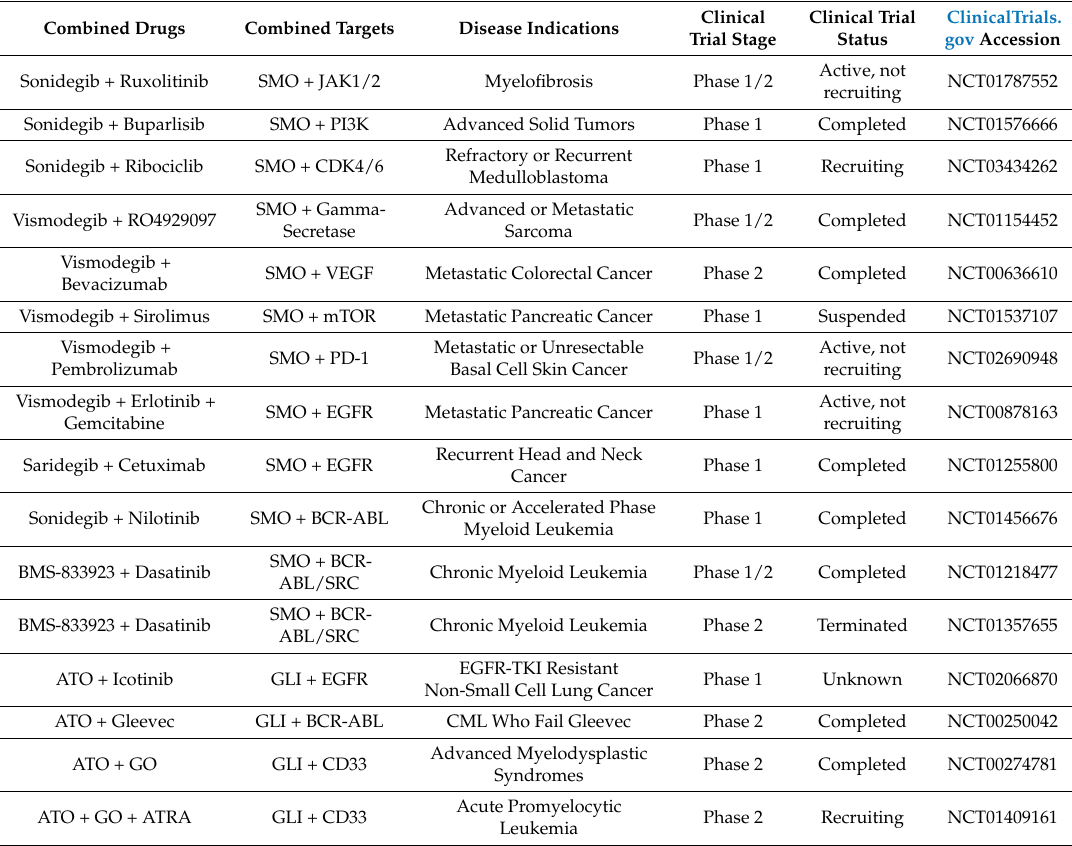
Table 1. Clinical trials of combination of Hedgehog (Hh) inhibitors and other targeted therapeutics. (Data from ClinicalTrials.gov